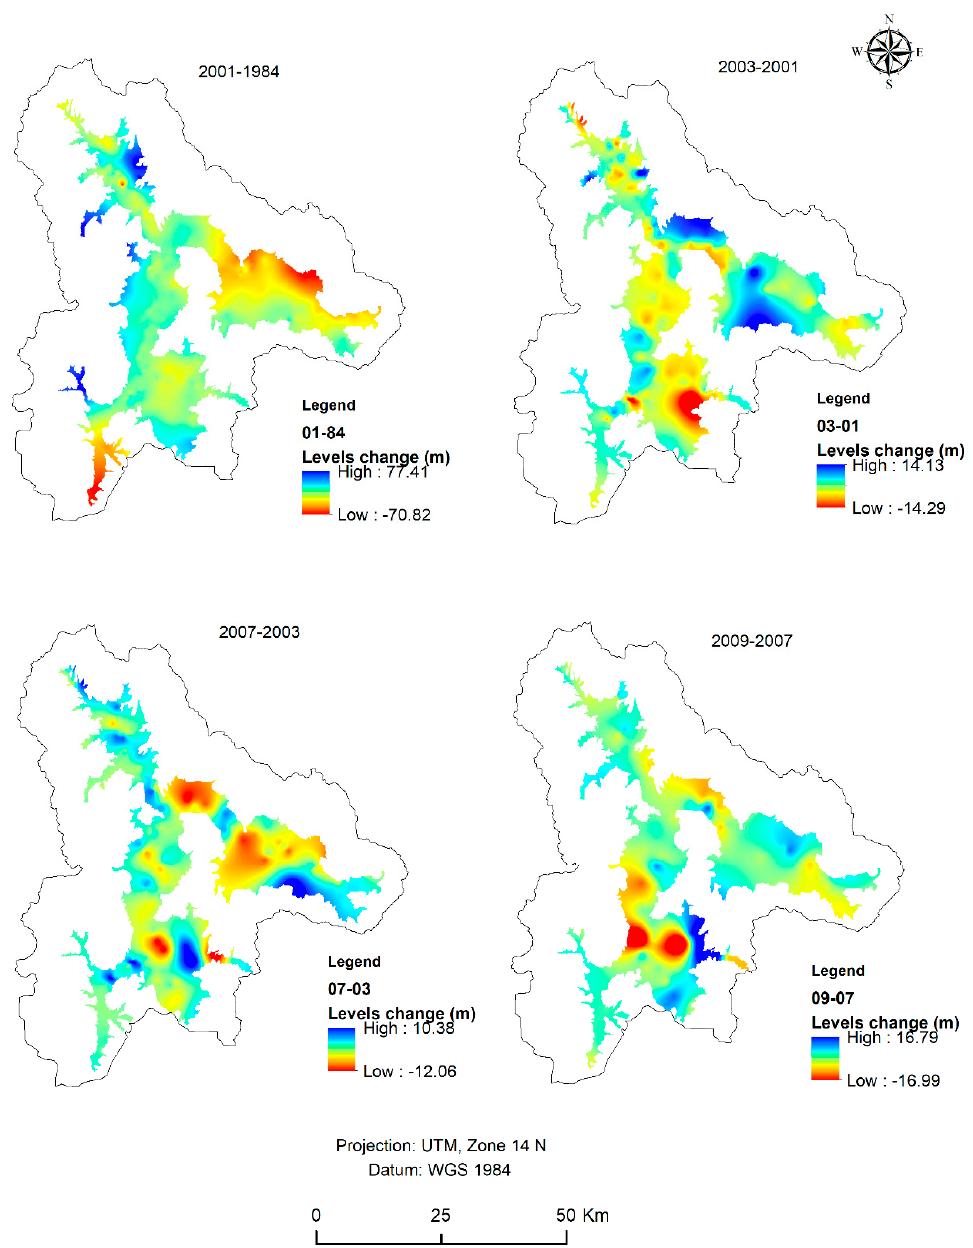
Figure 7. Volume storage change (in m) in the Central Valleys of Oaxaca during the dry seasons of 1984, 2001, 2003, 2007, and 2009